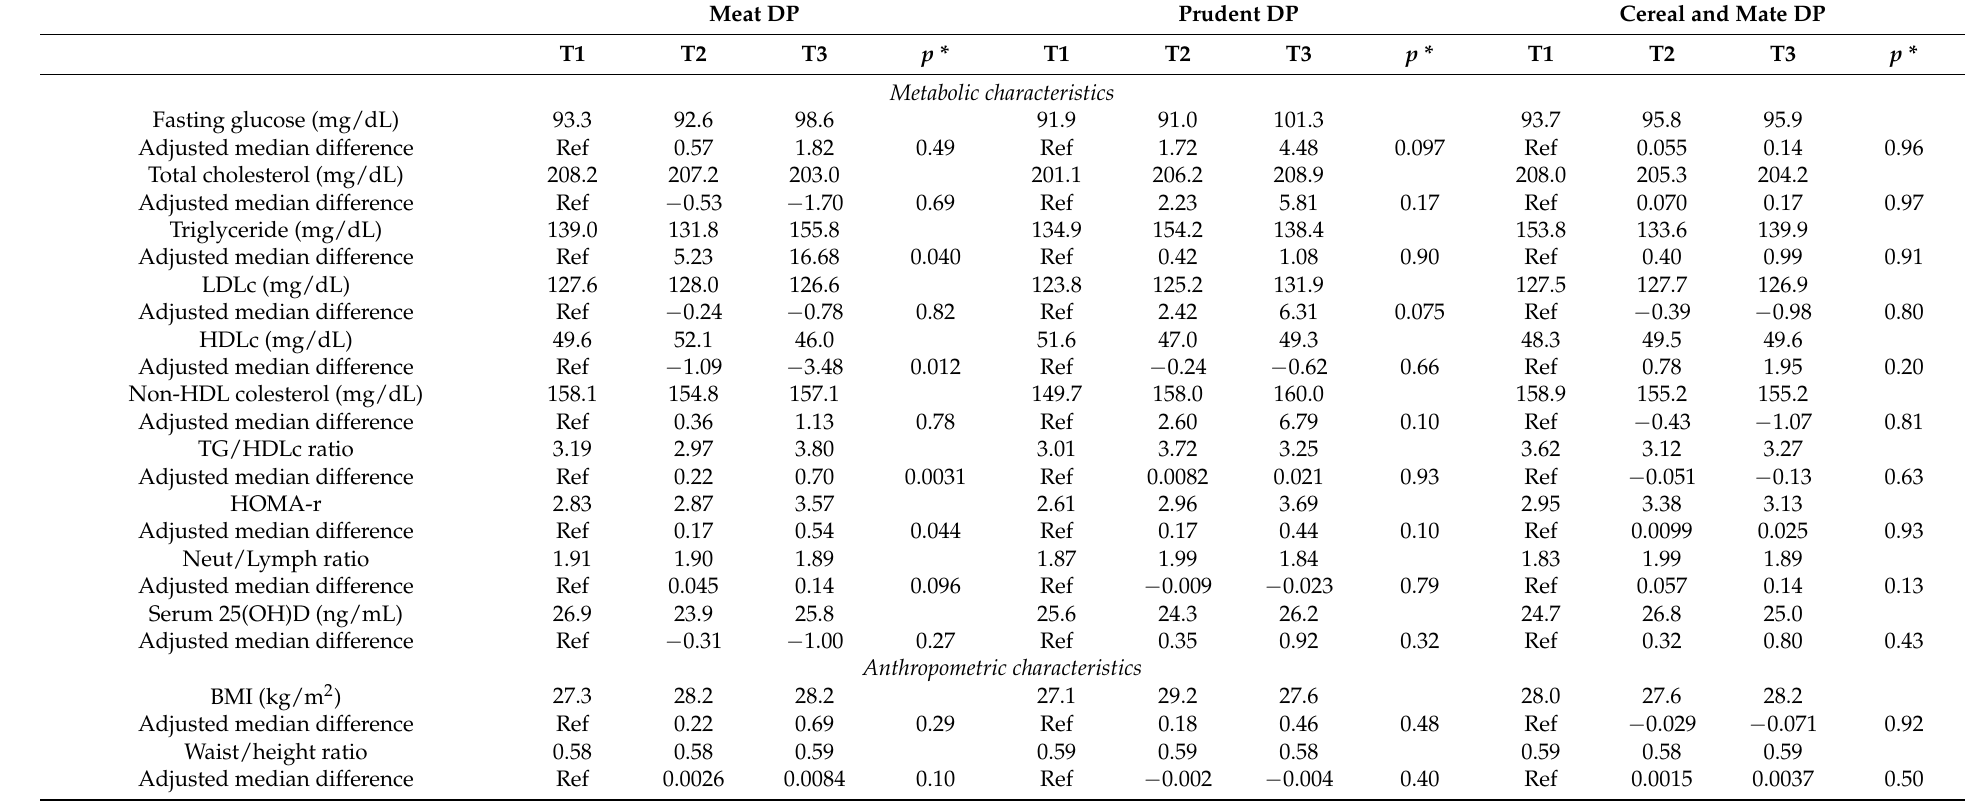
Table 4. Median metabolic, anthropometric, and cardiovascular and renal variables by tertiles (T) of dietary patterns in Uruguayan